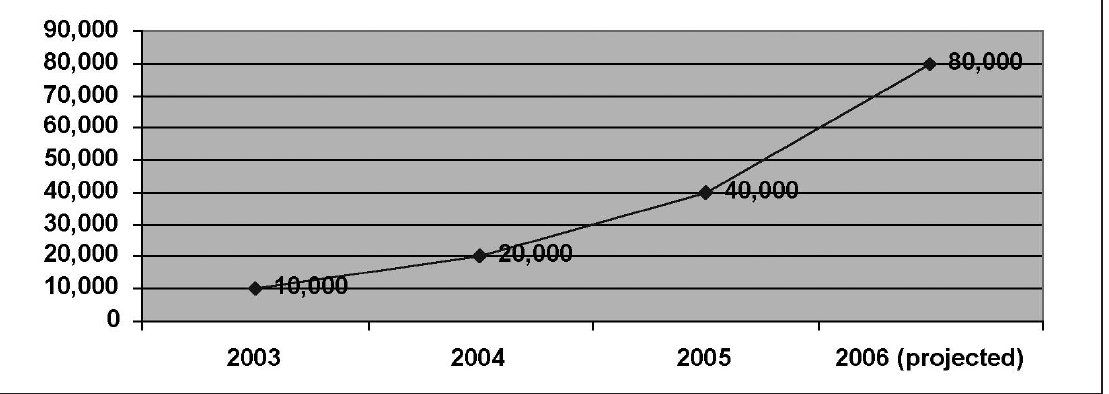
Figure 2. Unit Bar Soap Sales 2003–2006 (Projected) (Rounded to nearest thousand; data supplied by the